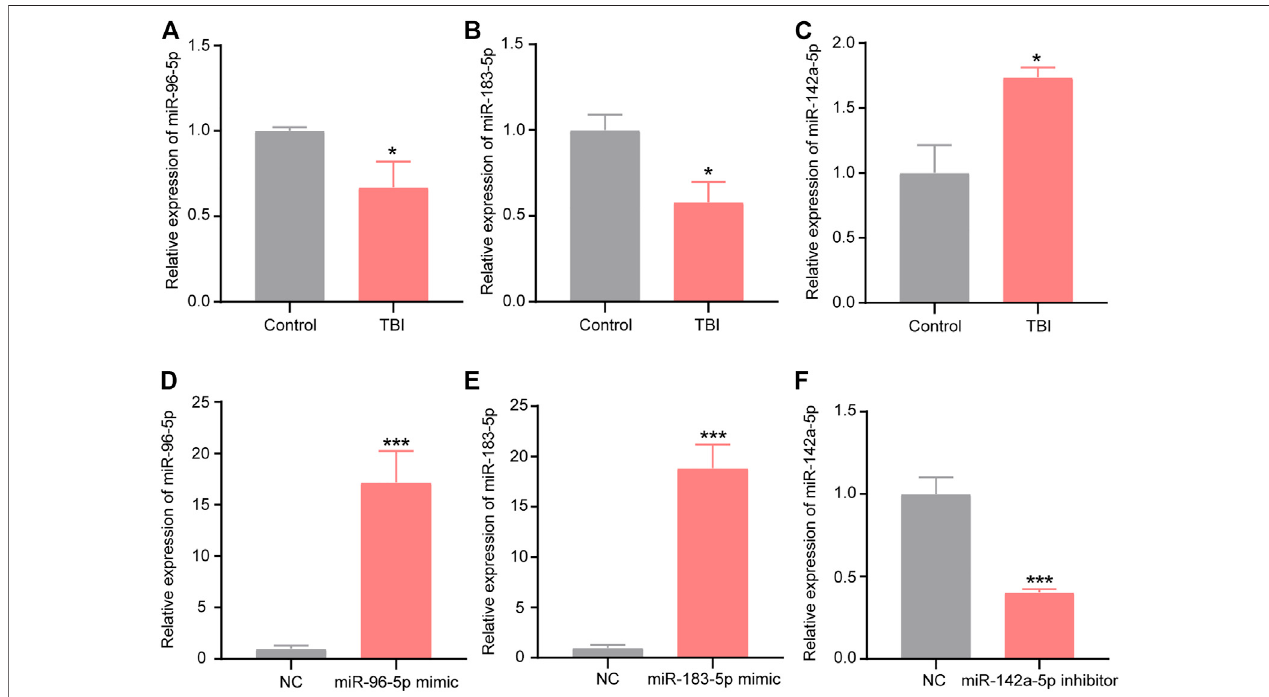
FIGURE9| ExpressionofmiR-96-5p (A) ,miR-183-5p (B) ,andmiR-142a-5p (C) inBV2cellswithscratchinjury(* p < 0.05,*** p < 0.01presentedTBIcomparedto controlgroup).qRT-PCRwasusedtodetecttheexpressionofmiR-96-5p (D) ,miR-183-5p (E) ,andmiR-142a-5p (F) intheBV2cellstransfectedwithmiR-96-5pmimic, miR-183-5p mimic, and miR-142a-5p inhibitor (* p < 0.05, *** p < 0.01 presented miRNAs compared to NC group). The data are exhibited as the mean ± SEM ( n = 3).